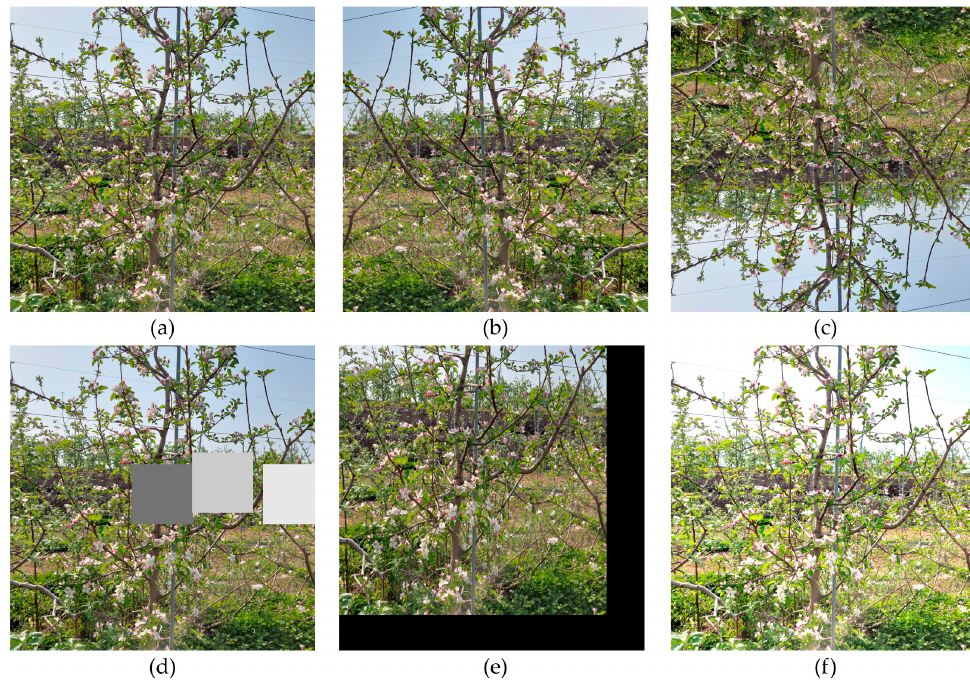
Figure 4. Image augmentation methods. ( a ) Original image; ( b ) Vertical flip; ( c ) Horizontal flip; ( d ) Cutout; ( e ) Random scaling; ( f ) Brightness transformation.